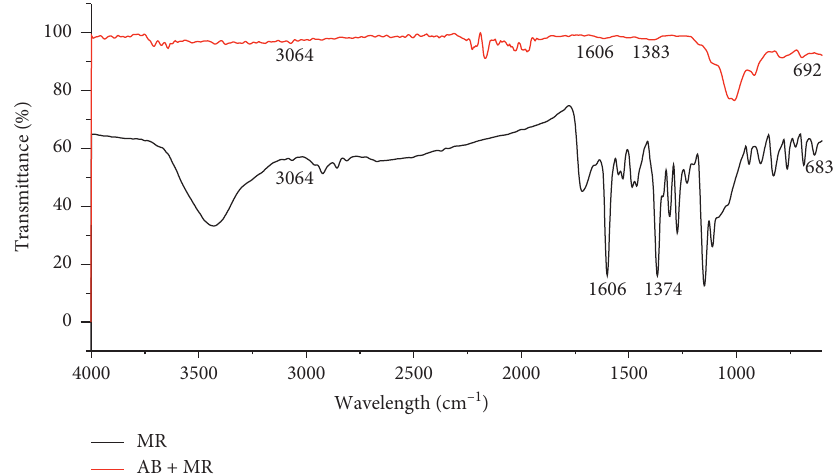
Figure 7: FTIR spectra of methyl red (MR) dye and after its adsorption by raw clay (MR+ANb).